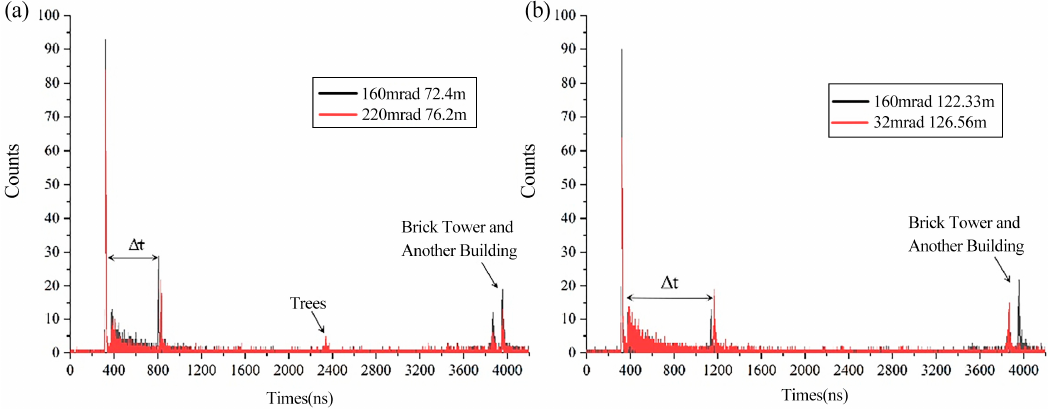
Figure 7. Search experiment at similar distances with different fields of view. ( a ) FOVs of 160 mrad and 220 mrad, which the target located near 75 m. ( b ) FOV of 32 mrad and 160 mrad, which targets near 125 m.